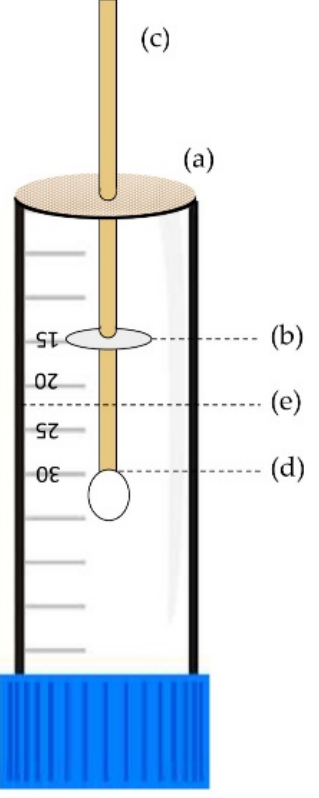
Figure 7. Vertical bioassay setup: the ‘v’ bottom of a Falcon tube was cut, and a mesh was hot glued over the opening (a). The filter paper with a thin layer of petroleum jelly was inserted 3 cm above the tip as a barrier and aligned with the 15 mL line of the falcon tube (b). A cotton swab was inserted through the tube and out the center of the mesh (c). The base of the cotton swab tip was aligned with the 30 mL marking on the tube and the treatment is applied evenly on the tip (d). The tick was released on the pencil marking 1.5 cm from the base of the cotton tip (e).